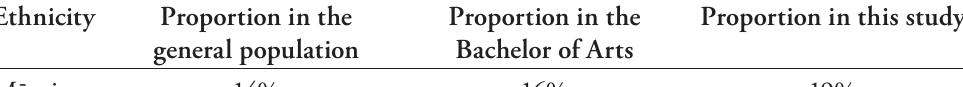
Table 1. Proportion of People from Māori or Pacific Backgrounds Ethnicity Proportion in the Proportion in the Proportion in this study general population Bachelor of Arts Māori 14% 16% 19% Pacific 7% 8%